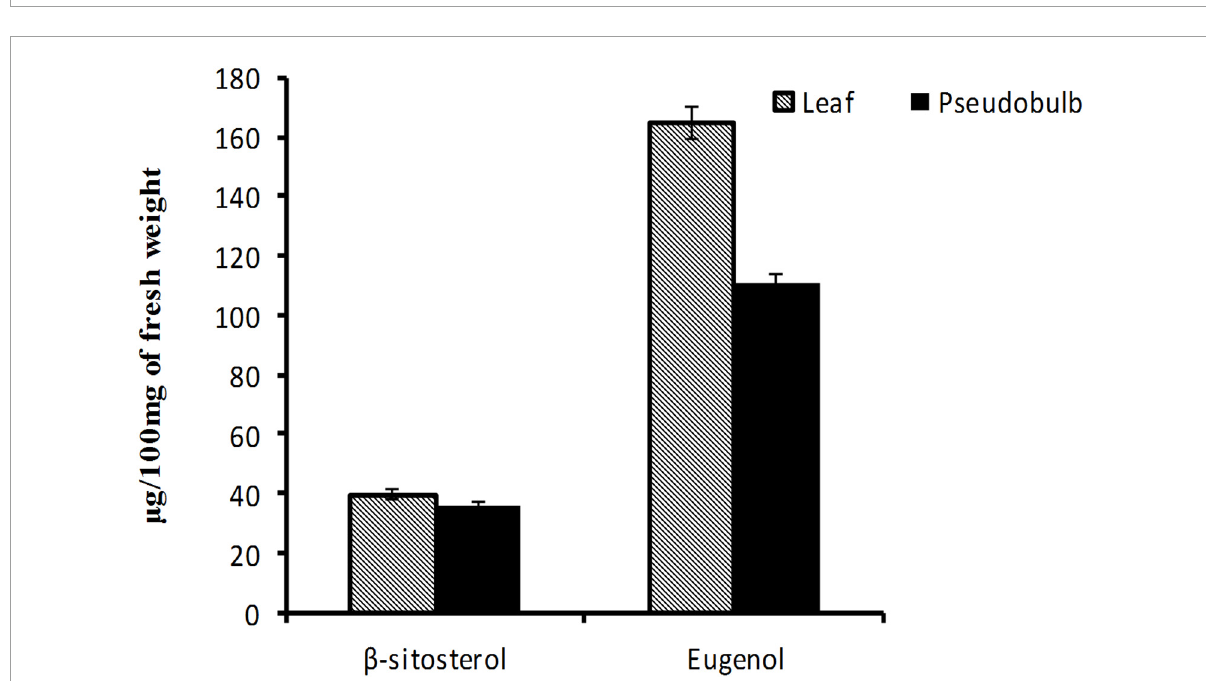
associated with response to wounding, defense response to fungus, cell growth, and response to abscisic and jasmonic acid stimulus were upregulated in pseudobulb as compared